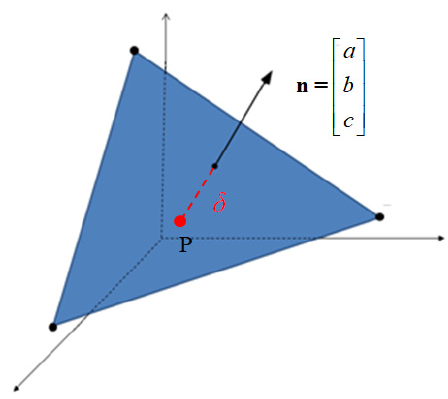
Figure 18. Calculation methods for sinkage to an arbitrary point from a plane.